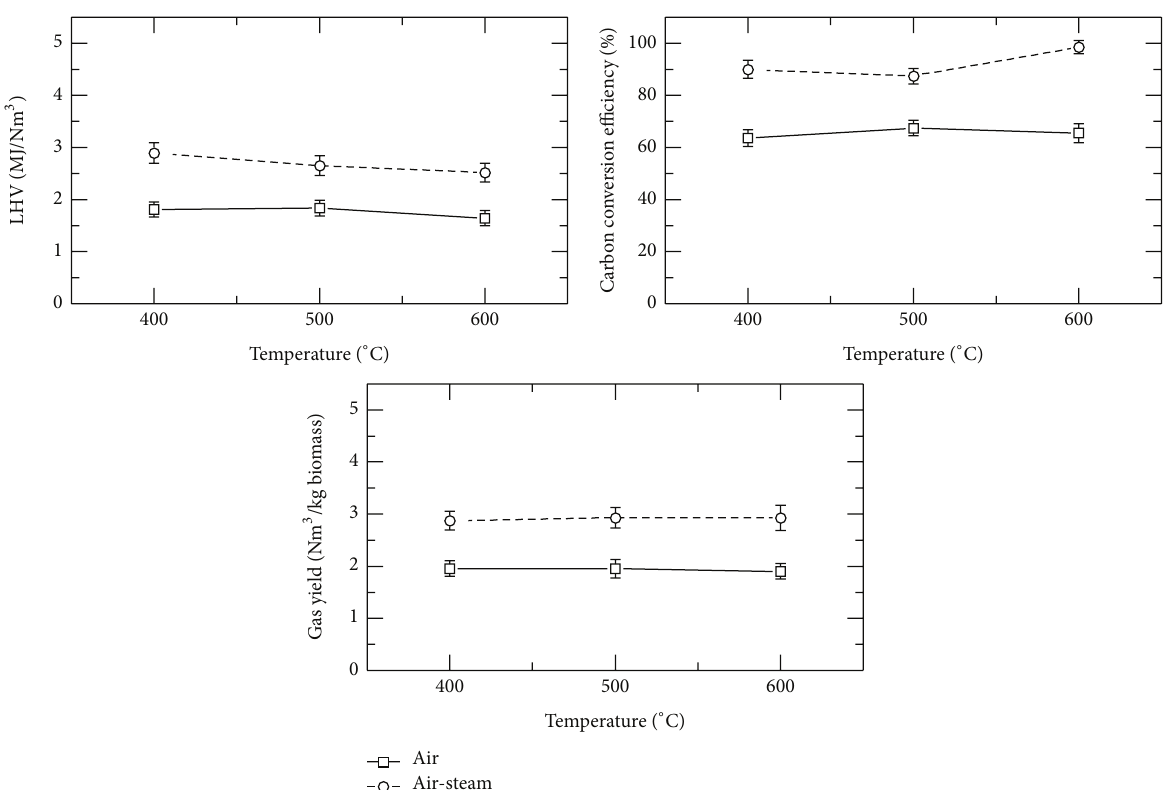
process. This was so because higher contents of H 2 , CO, and CH 4 were expected from the water-gas reaction